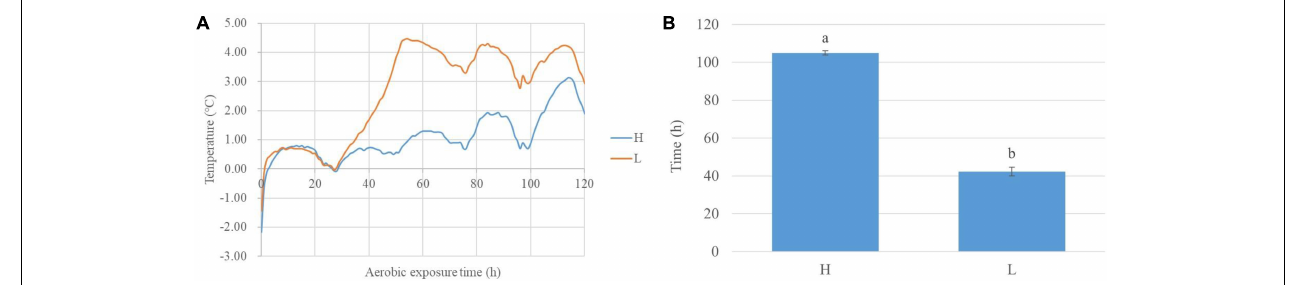
FIGURE 1 | The degree of silage temperature ( ◦ C) above ambient temperature in whole-plant corn silage during aerobic exposure (A) and the time of silage temperature with 2 ◦ C above ambient temperature (B) . H, ensiled whole corn plants with a high moisture content (680 g/kg) harvested at the one-third milk-line stage; L, ensiled whole corn plants with a low moisture content (620 g/kg) harvested at the two-thirds milk-line